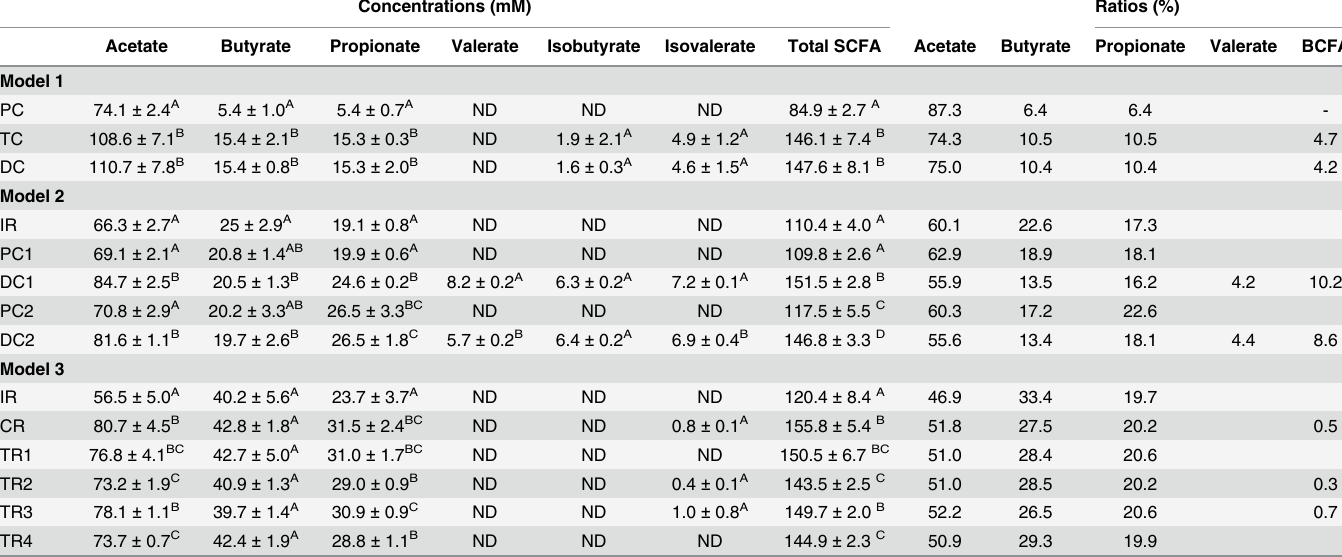
Table 2. Metabolites concentration (mM) and ratios (%) measured by HPLC in effluent samples of models ’ reactors at the end of the stabilization period.